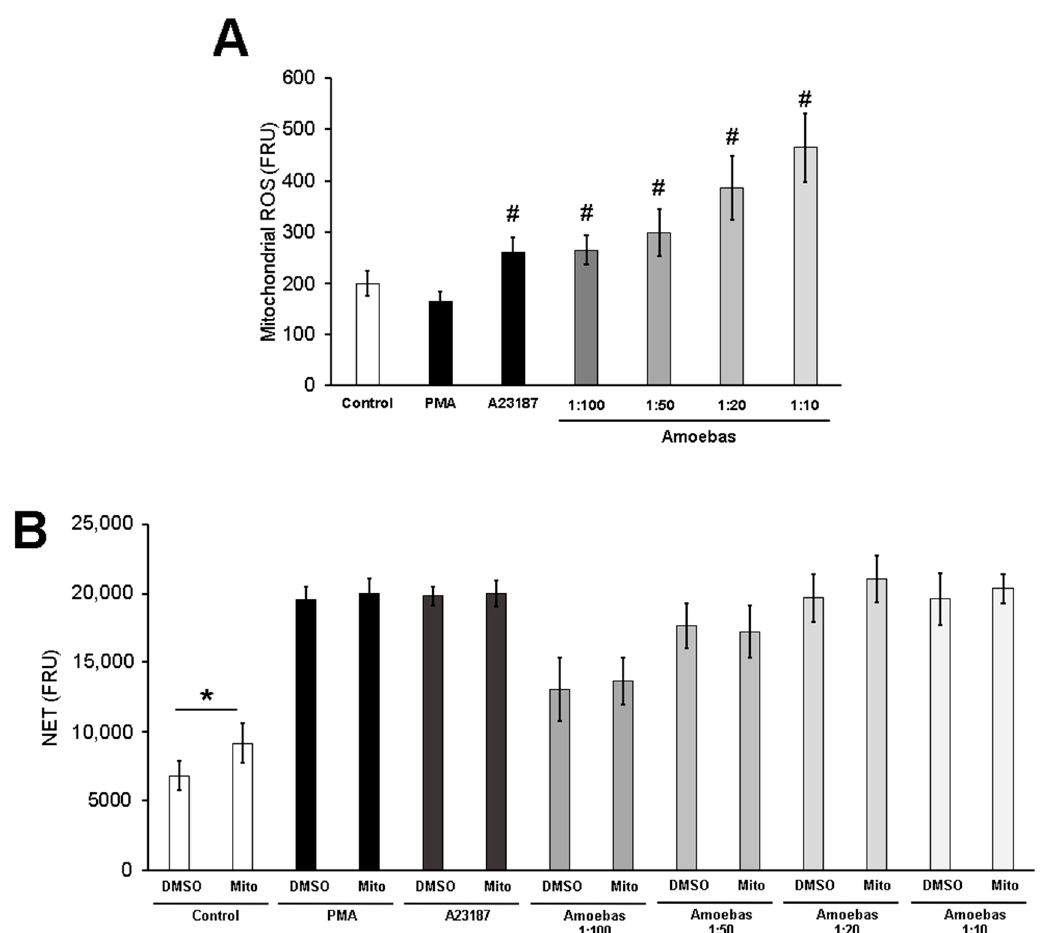
Figure 9. Mitochondrial ROS are not necessary for E. histolytica -induced NETosis. ( A ) MitoSOX TM red-pretreated neutrophils (1 × 10 5 ) were cultured in RPMI-1640 medium supplemented with 5% FBS and then stimulated with PMA (50 nM), A23187 (10 µ M) or E. histolytica trophozoites at ratios 1:100, 1:50 or 1:20. Fluorescence was read at 2 h. ( B ) Neutrophils (1 × 10 5 ) were pretreated with 400 µ M mitoTEMPO (Mito) or DMSO for 30 min. Posteriorly, cells were transferred to RPMI-1640 medium added with 5% FBS and 500 nM SYTOX ® Green and then stimulated with PMA (50 nM), A23187 (10 µ M) or E. histolytica trophozoites at ratios of 1:100, 1:50, 1:20 and 1:10. Fluorescence was read at 4 h. ROS and NET amount are expressed in fluorescence relative units (FRU). Values are means ± SD of three independent experiments. # p < 0.001 with respect to the control, * p < 0.01.